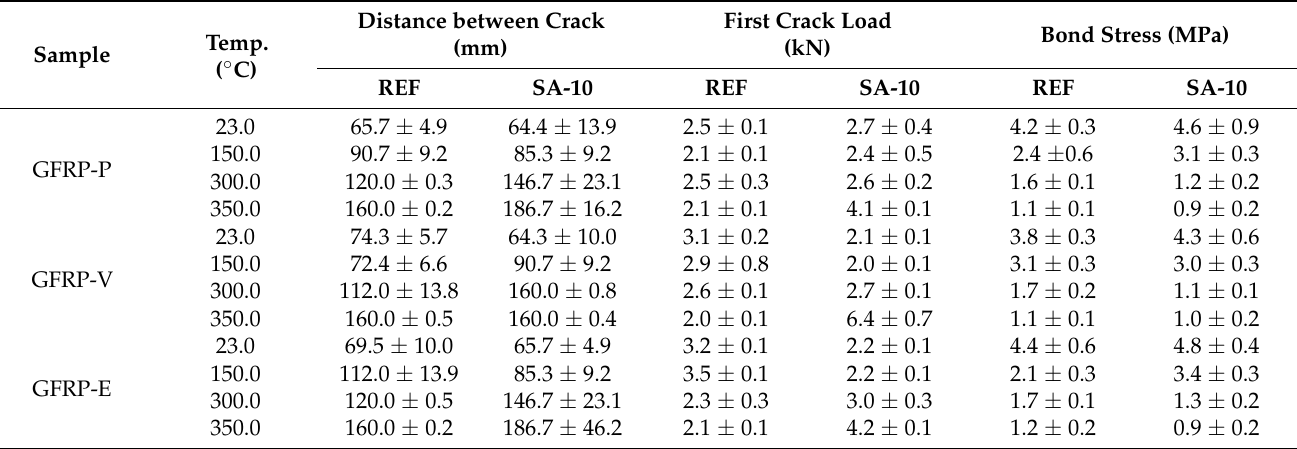
Table 7. Bond stress, distance between cracks, and first crack load results GFRP bars with covered concrete at elevated